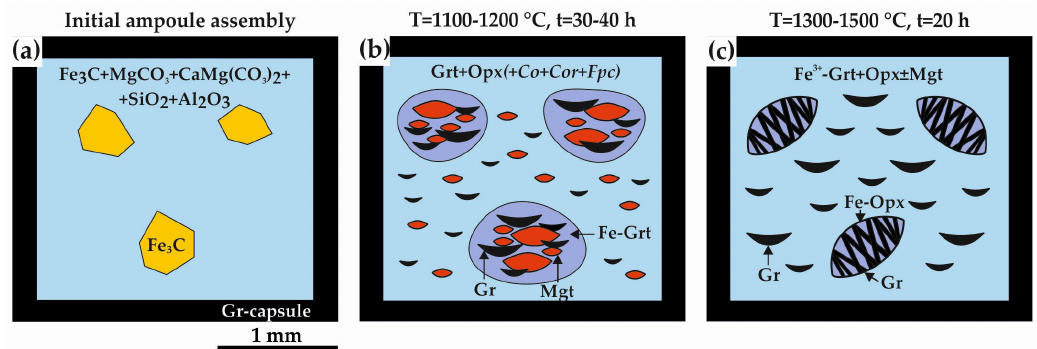
Figure 5. Data were taken from the polished samples, coated with carbon. Grt, garnet; Opx, orthopyroxene; Figure 5. Schemes of carbide–oxide–carbonate interaction in the “mixture-type” experiments (Fe 3 C– Mgt, magnetite; Fpc, ferropericlase; C, center; R, rim; N A , number of electron probe analyses used to Al 2 O 3 –SiO 2 –(Mg,Ca)CO 3 system, P = 6.3 GPa): ( a ) initial ampoule assembly (before experiments); ( b ) obtain the average compositions. The values in parentheses are one sigma errors of the means based samples after experiments at 1100–1200 °C, t = 30–40 h; and ( c ) samples after experiments at 1300– on replicate electron microprobe analyses reported as least units cited. *, calculated according to 1500 °C, t = 20 h. Grt, garnet; Coh, cohenite; Mgt, magnetite; Opx, orthopyroxene; Fe-Opx, Fe-rich Mössbauer spectroscopy data. orthopyroxene; Gr, graphite; Fe 3+ -Grt, garnet, enriched with trivalent iron, Fpc, ferropericlase. Table 6. Average compositions of silicates and oxides in the carbide–oxide–carbonate system (“mixture-type” experiments) at 6.3 GPa, according to microprobe analysis.